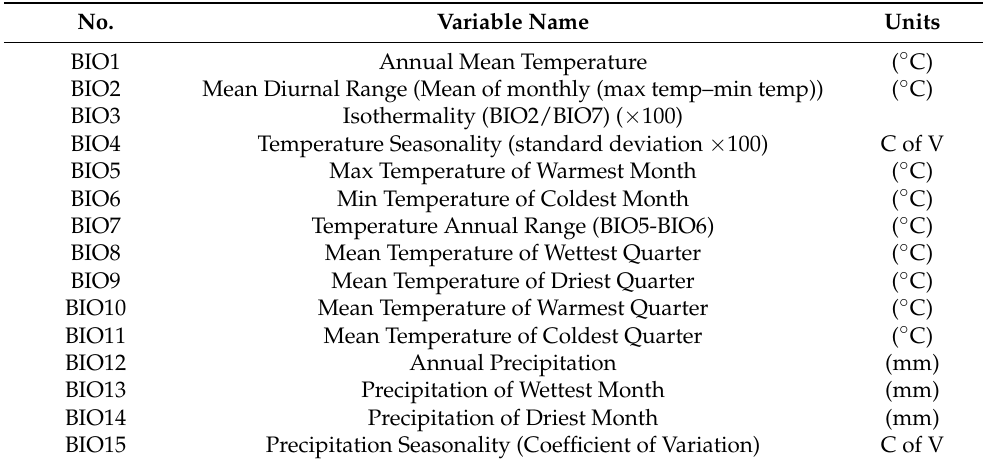
Table 1. Names and units of bioclimatic